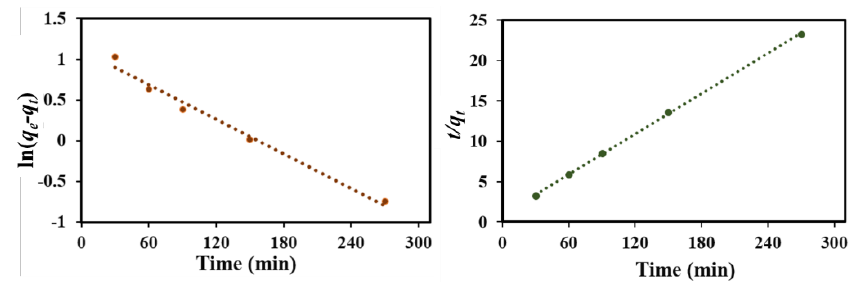
Figure 12. Adsorption kinetics of NOR on MNPC ( a ) pseudo-first-order and ( b ) pseudo-second-order models.